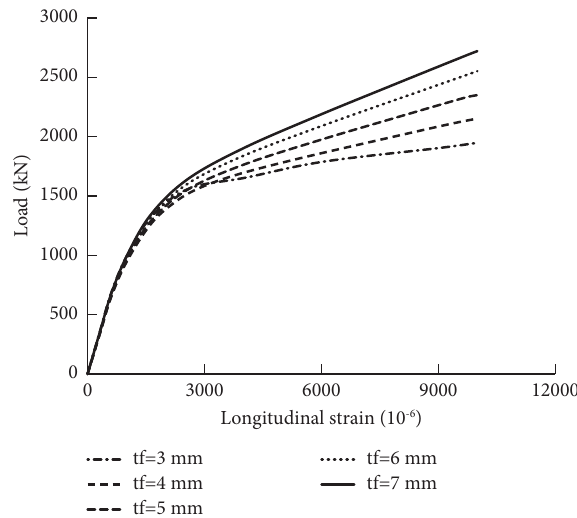
Figure 11: Te infuence of GFRP tube thickness.